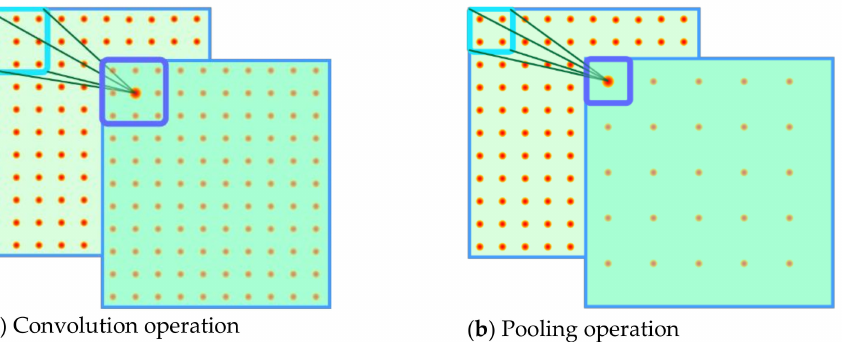
Figure 7. The extraction process of convolution and pooling layers.